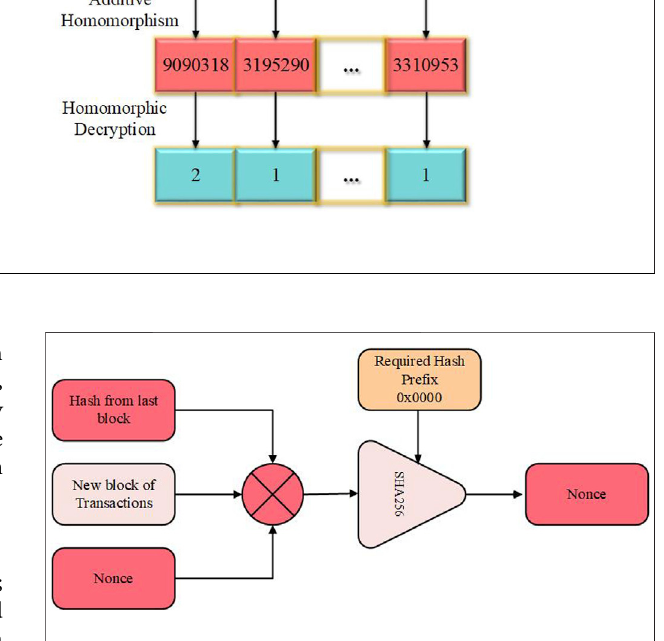
FIGURE 3 | Proof-of-work (PoW)